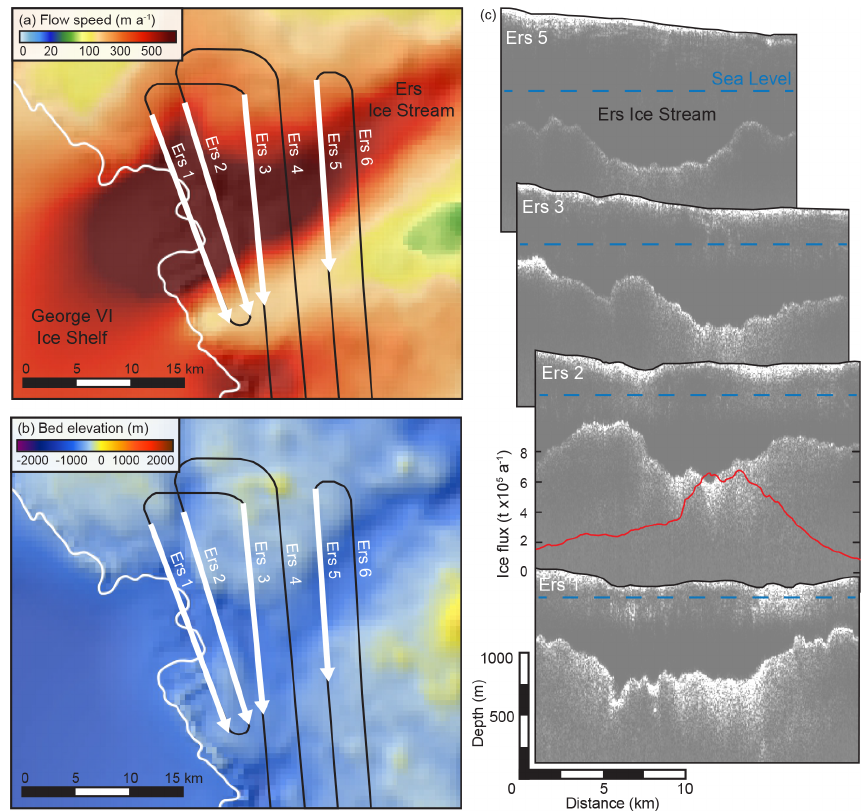
Figure 3. Ice-penetrating radar transects (black lines) across Ers Glacier, superimposed on a map of surface flow speeds (Mouginot et al., 2019a) (a) and subglacial topography from BedMachine (Morlighem, 2019) (b) . White arrows indicate the location and direction of radargrams presented in panel (c) whilst the white line indicates the ASAID grounding line (Bindschadler et al., 2011). Ice flux across RES transect Ers 2 is displayed as a red line in panel (c) . Note that the scale is in tonnes × 10 5 . (c) Radargrams reveal surface topography, ice thickness and the subglacial bed (recorded as diffuse white reflectors). Sea level is marked by a blue dashed